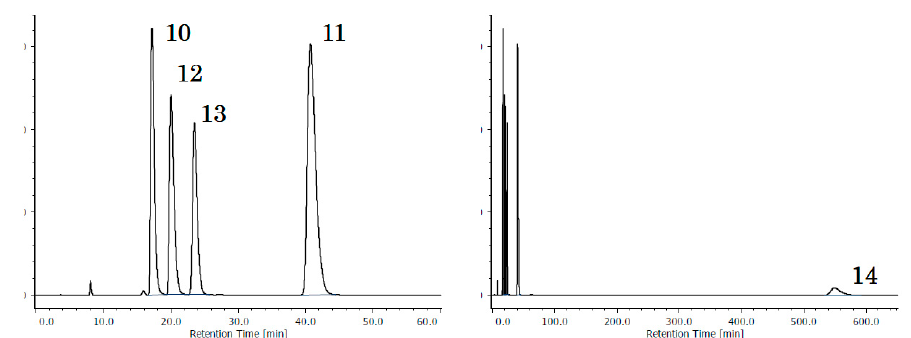
Figure 1. Chromatograms of isomeric acetyl phenanthrenes and anthracenes. Upper: On CHIRALCEL ® OJ-H. Lower: On CHIRALCEL ® OD-H. In each subfigure, the right side shows the total chromatogram and the left shows its 0–60 min range, enlarged. The elution order was totally inverse, except the one between 11 and 14 . The mobile phase was a mixture of hexane and 2-propanol in 100:1 ( v / v ) ratio. For other conditions, see Section 3. Materials and Methods.